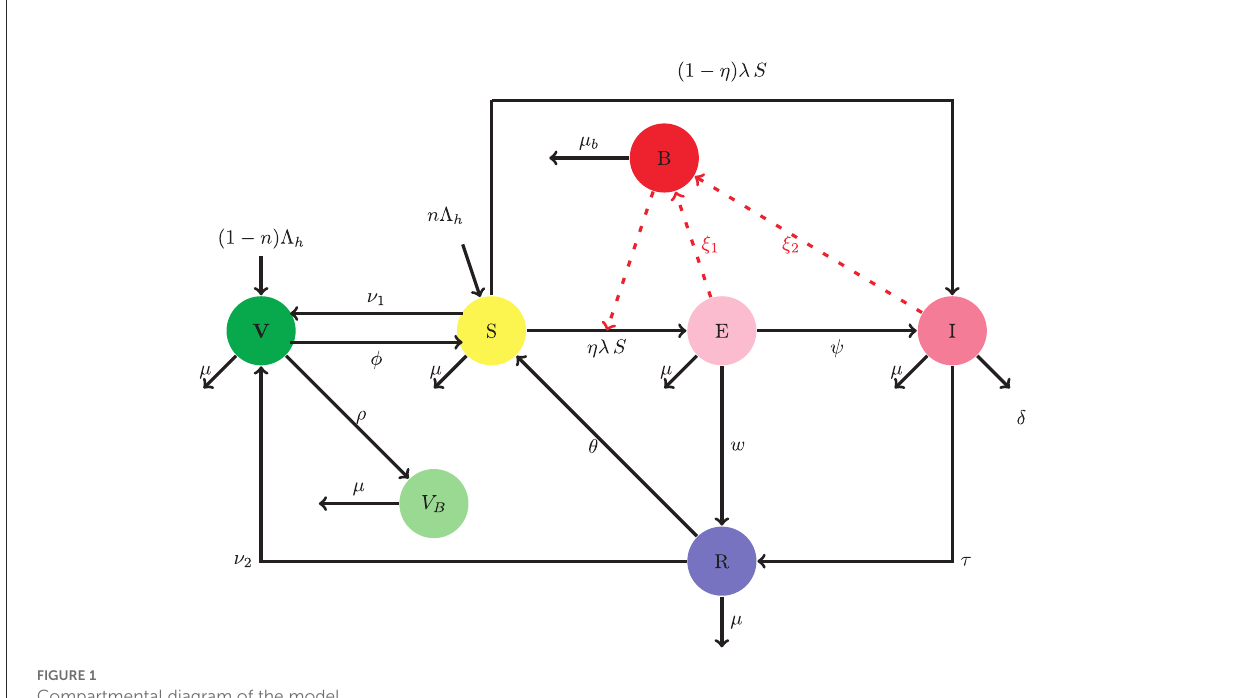
FIGURE1 Compartmental diagram of the model.